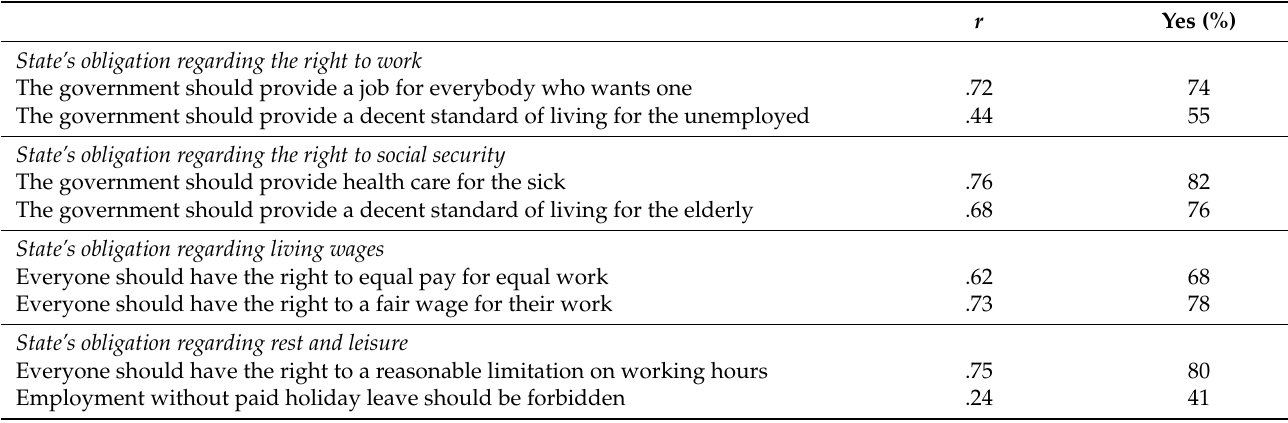
Table 1. Scale of Attitude toward Socio-economic Human Rights (SASHR): Scale properties.